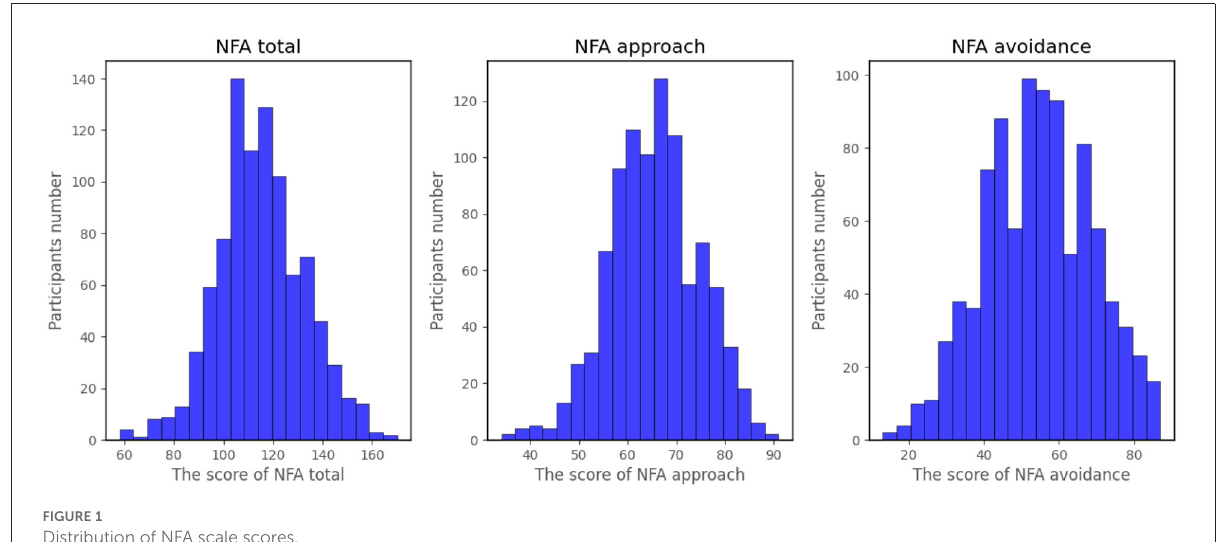
FIGURE1 Distribution of NFA scale